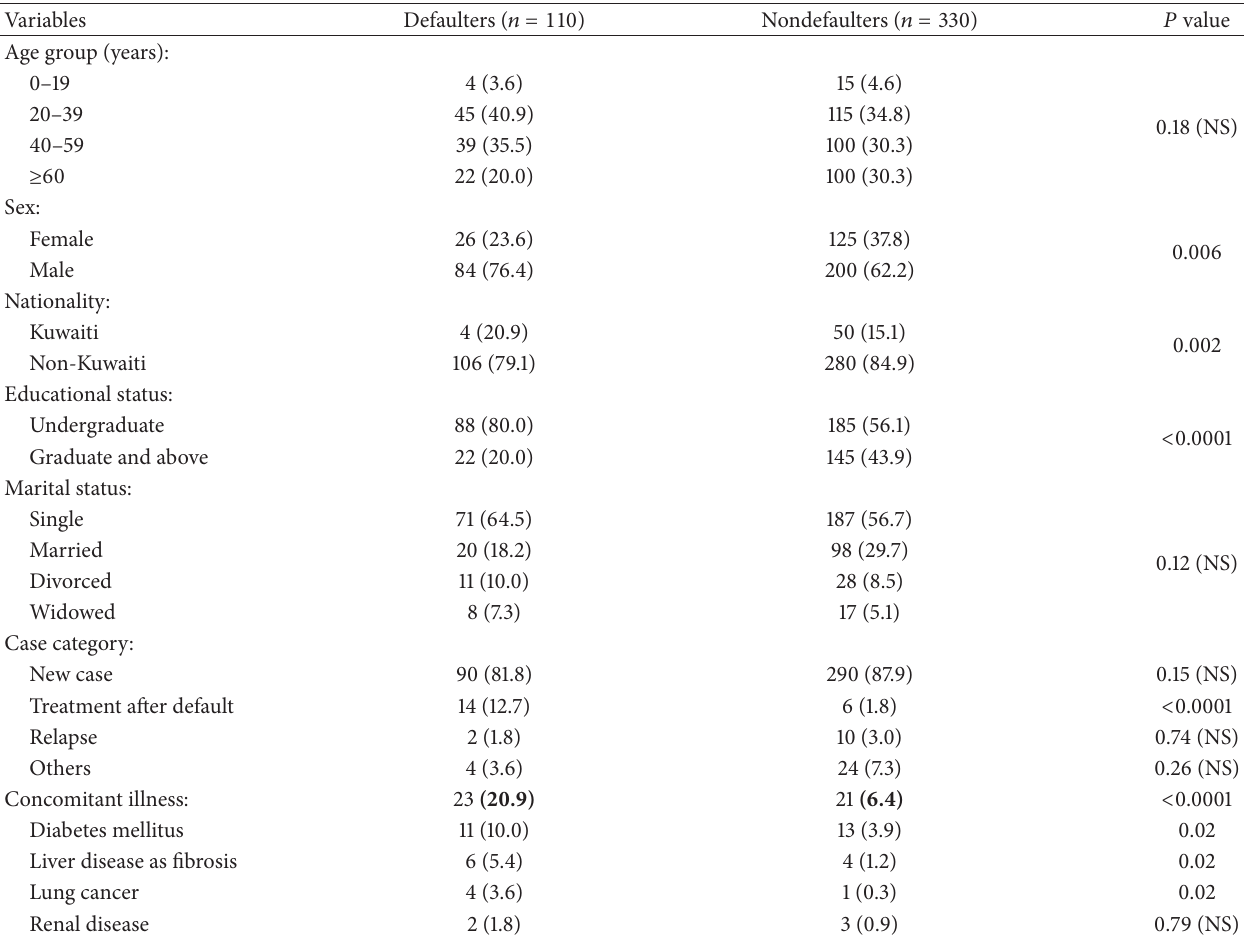
Table 2: Demographic characteristics of defaulters and